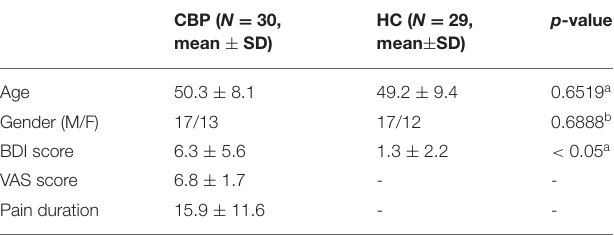
TABLE 1 | Demographic information of